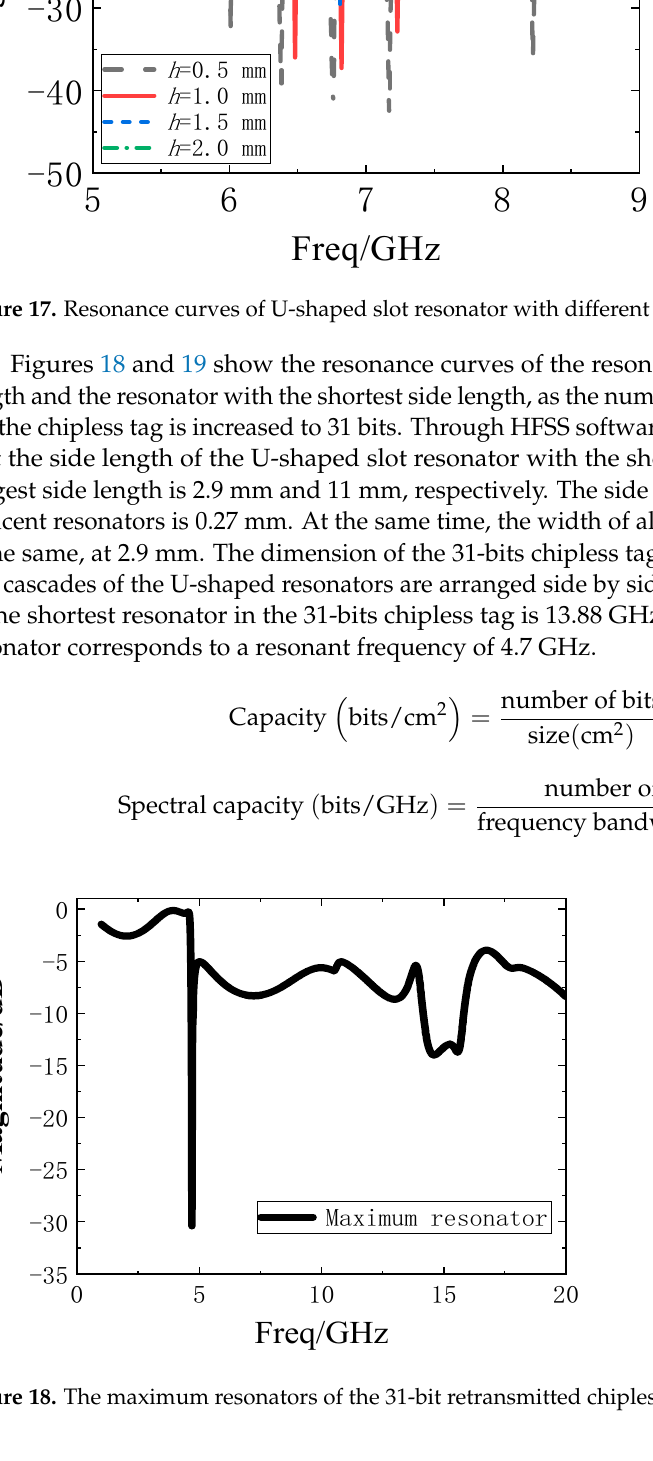
Figure 17. Resonance curves of U-shaped slot resonator with different substrate thickness.